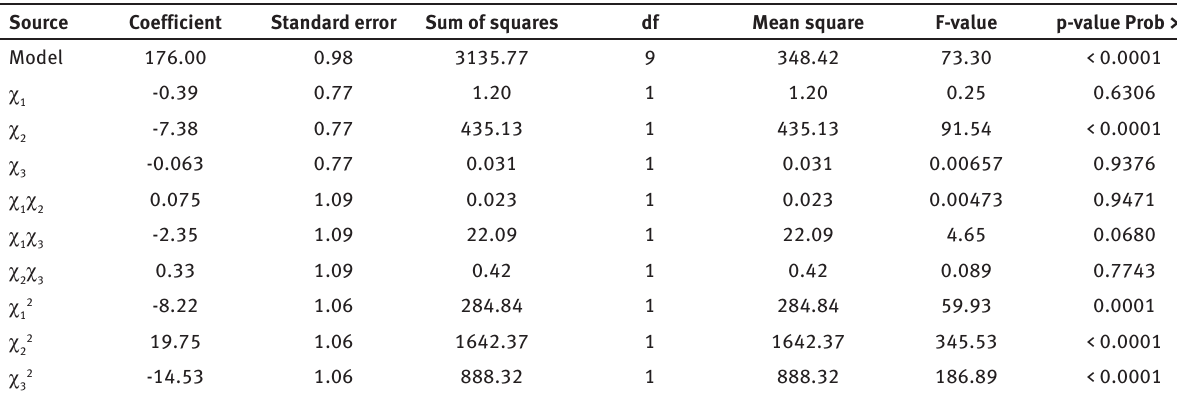
Table 6: Variance (ANOVA) analysis for quadratic model.